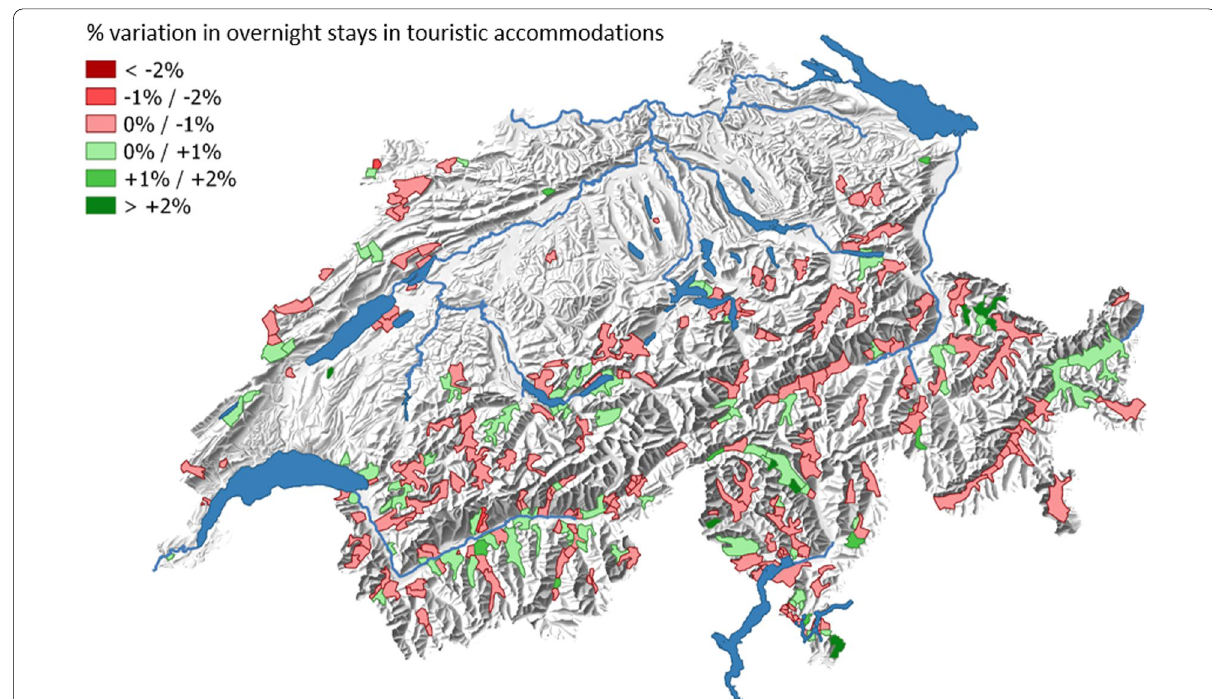
Fig. 6 Restricted to new second home construction municipalities: Variation in percentage of touristic overnight stays in managed accommodations. Source : Author’s illustration of the data from the FSO tourist accommodation